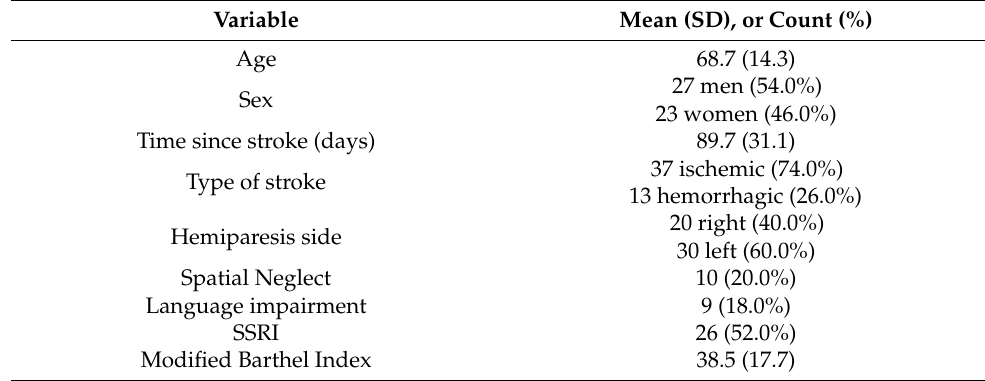
Table 1. Demographic and clinical characteristics of the sample ( n = 50) at enrollment